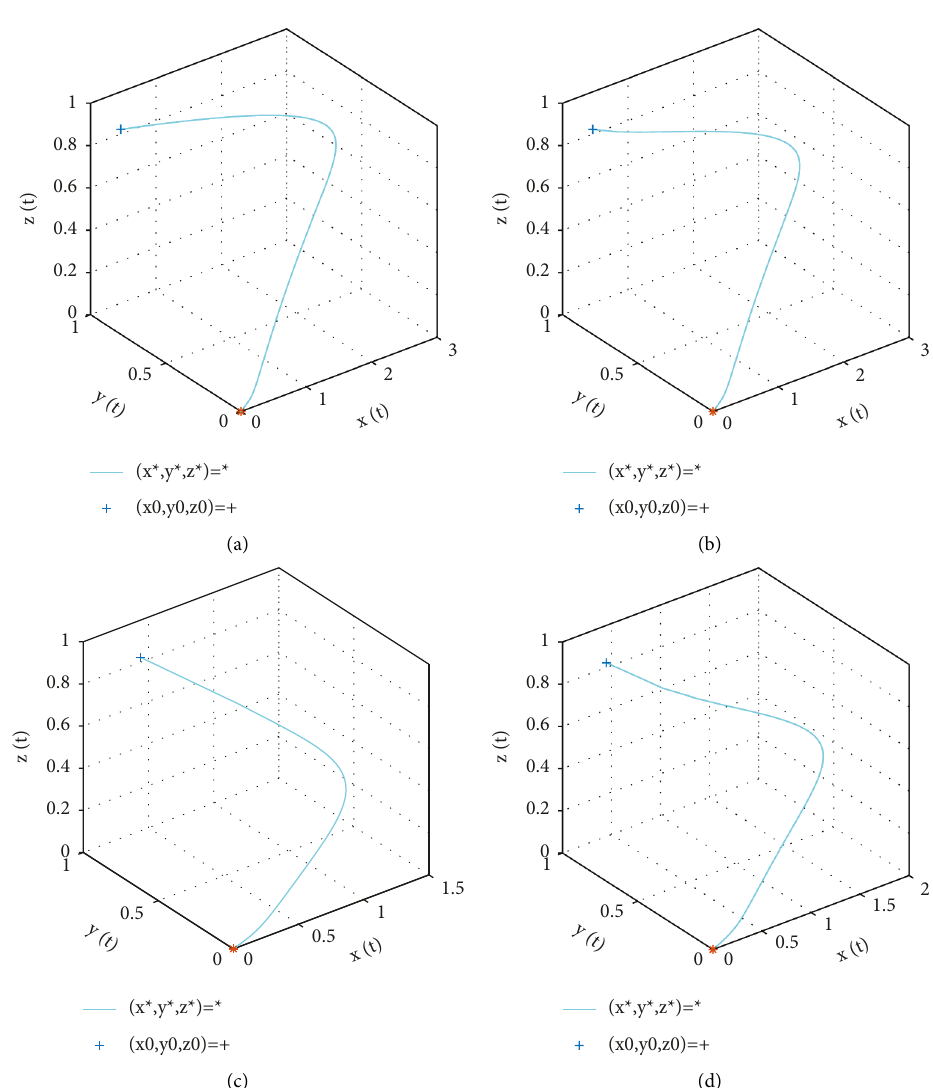
Figure 1: Shows the local stability of the equilibrium point e at which x ( t ) represents immature prey species, y ( t ) represents mature prey 0 species, and z ( t ) represents predator species. The values in Table 1 are used with different values of fractional-order(a) q � 1, (b) q � 0 . 98, (c) q � 0 . 88, and (d) q � 0 . 78.